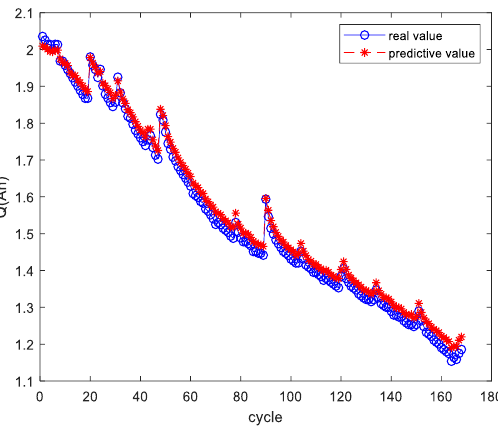
Figure 6. B6 battery capacity estimation